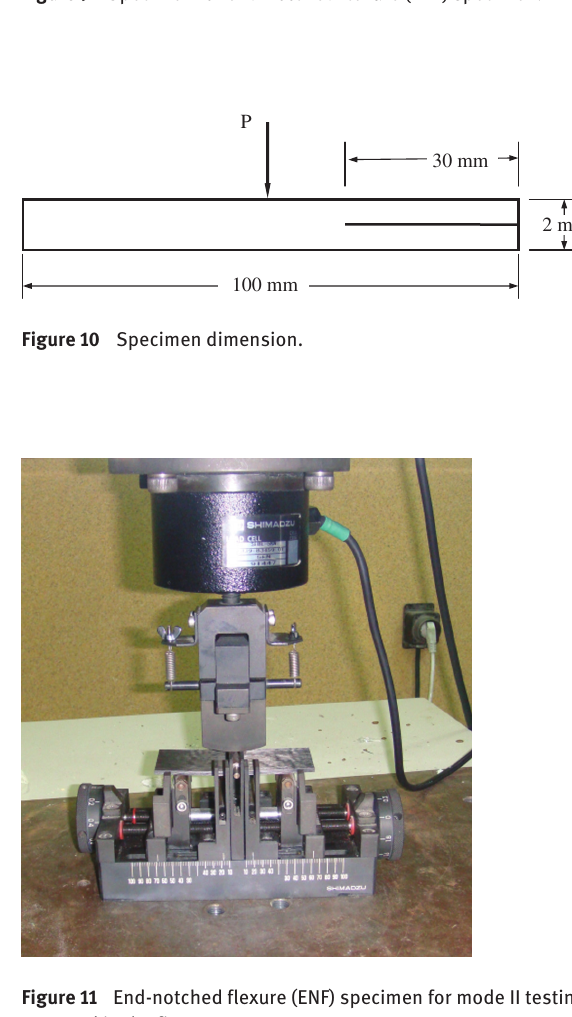
Figure 9 Specimen for end-notched flexure (ENF) specimen.